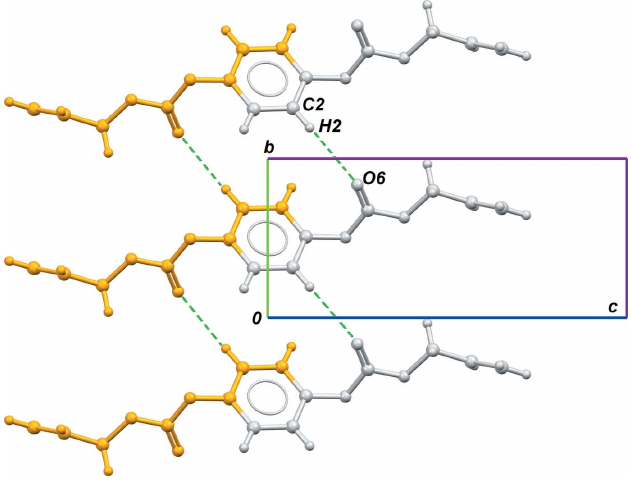
Figure 3 Part of the crystal structure based on C2—H2 (cid:2)(cid:2)(cid:2) O6 interactions (Table 1, entry 2). Grey fragments are generated from the asymmetric unit by lattice translations, and orange fragments are generated by